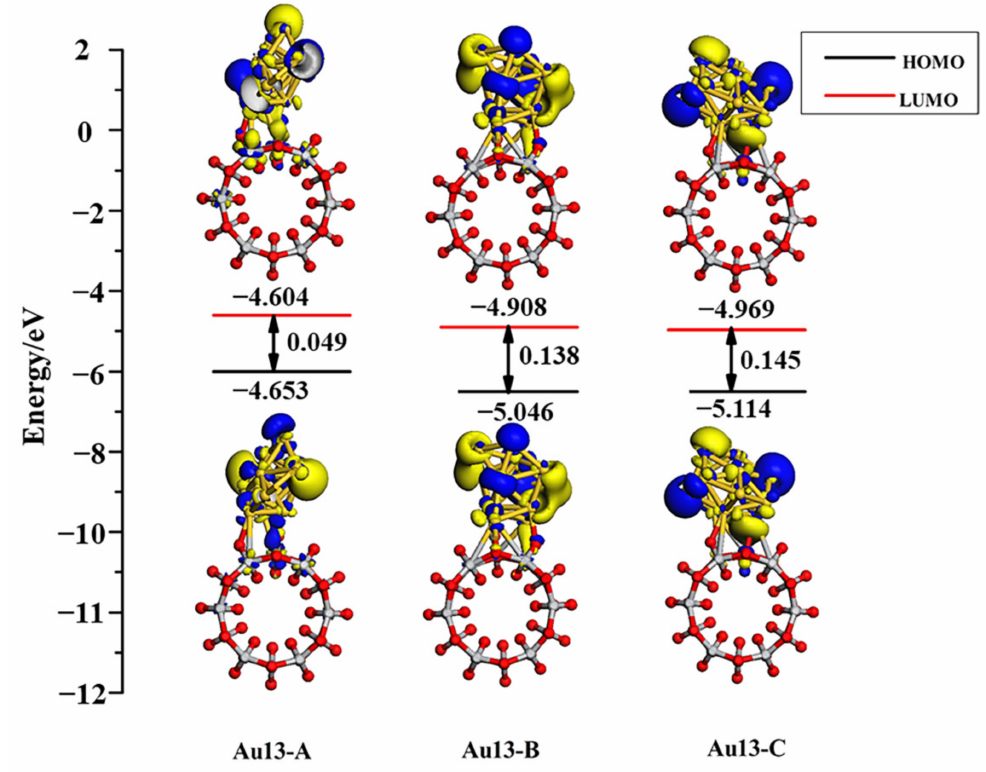
Figure 11. HOMO and LUMO along with the energy gap of four Au 13 adsorption systems calculated at the Γ -point. The isovalue set is 0.025 electrons/Å 3